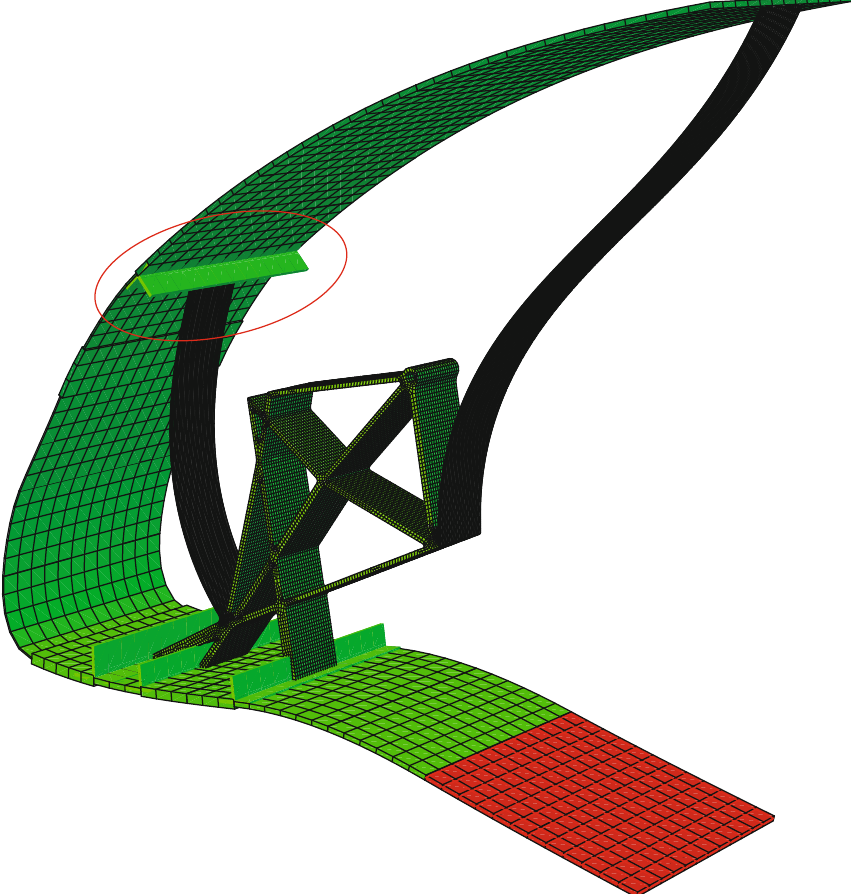
Figure 3: Finite element model of a wing section of the droop nose with the inspection panel and the new hinged connection to the top skin.